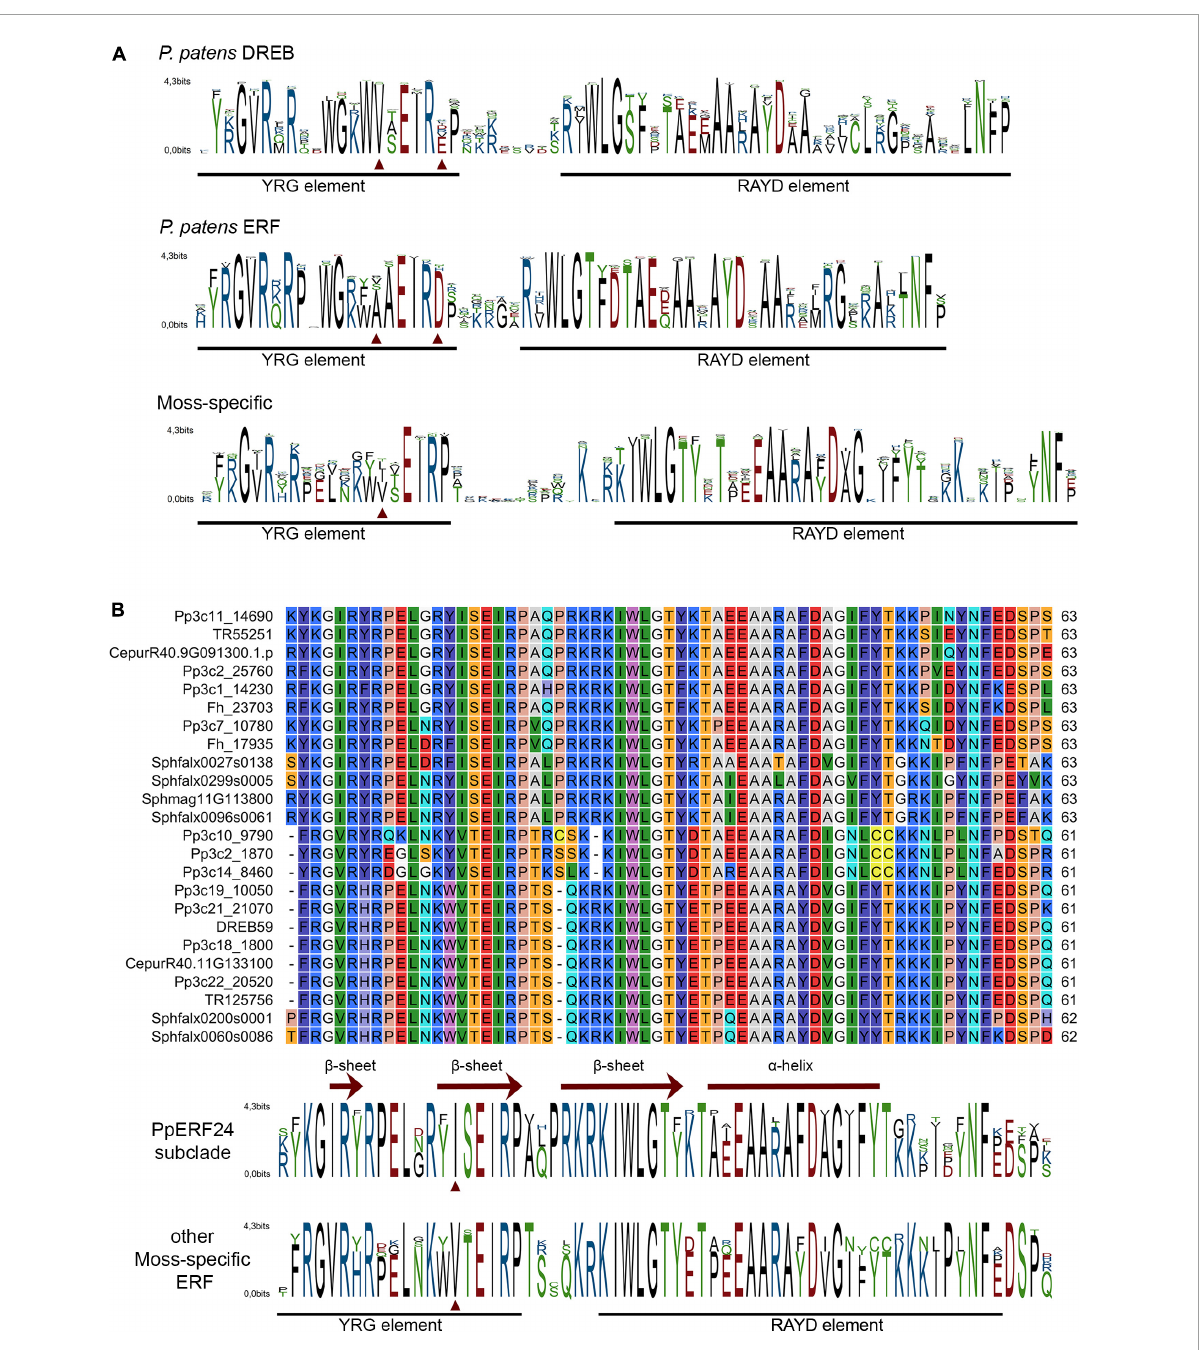
FIGURE2 Conserved motifs in the AP2 domain of mosses ERF family clades (A) . Sequence logos of AP2 domain from P. patens DREB clade, P. patens ERF clade, and moss-specific clades. (B) Alignment of PpERF24 and several AP2 domains of the moss-specific clade and corresponding sequence logos. Conserved YRG and RAYD elements are indicated with a black line, and conserved amino acids 14 and 19 for members of the DREB and ERF clades and 15 for PpERF24 and moss-specific AP2 domains are marked with red arrows. The β -sheets and α -helix predicted for PpERF24 are